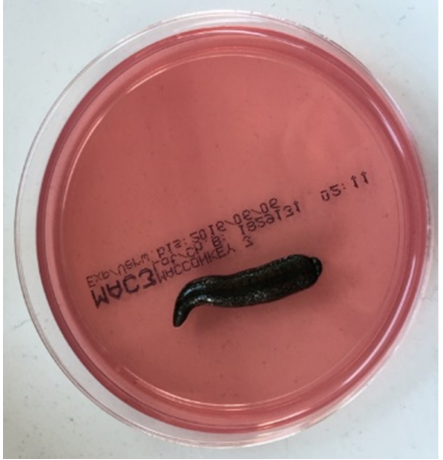
Figure 1. Leech on MacConkey Agar